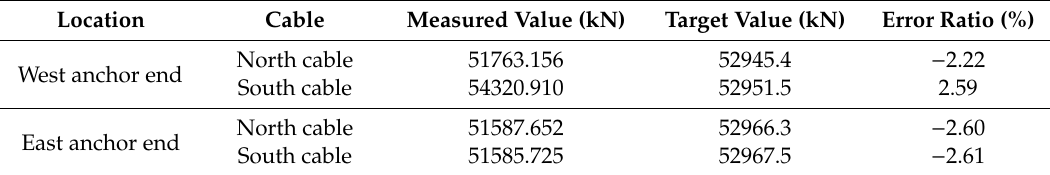
Figure 21. Measured girder alignment at completion state and error. Table 10. Comparison of cable force at completion